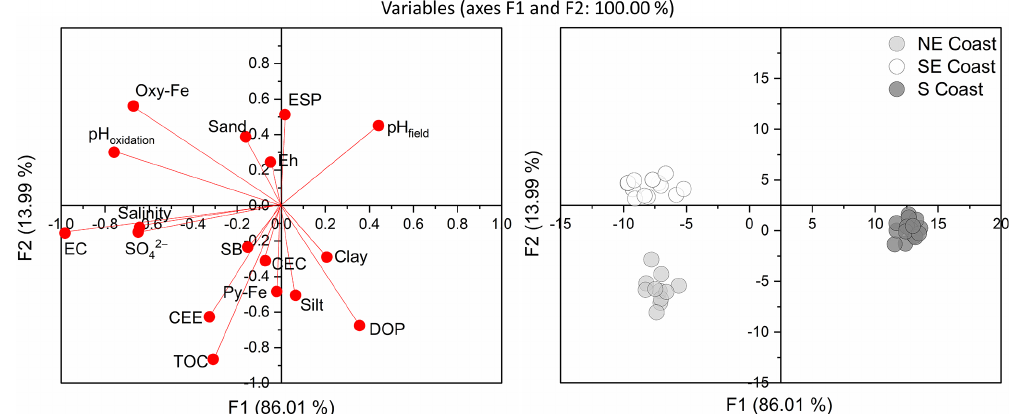
Figure 5. Discriminant analysis (DA) showing the differentiation of the seagrass soils from the three studied coastal compartments (north- eastern coast, southeastern coast, and southern coast). CCE: calcium carbonate equivalent; CEC: cation exchange capacity; EC: electrical conductivity; ESP: exchangeable sodium percentage; Oxy-Fe: Fe oxyhydroxides; Py-Fe: pyritic Fe; TOC: total organic carbon.